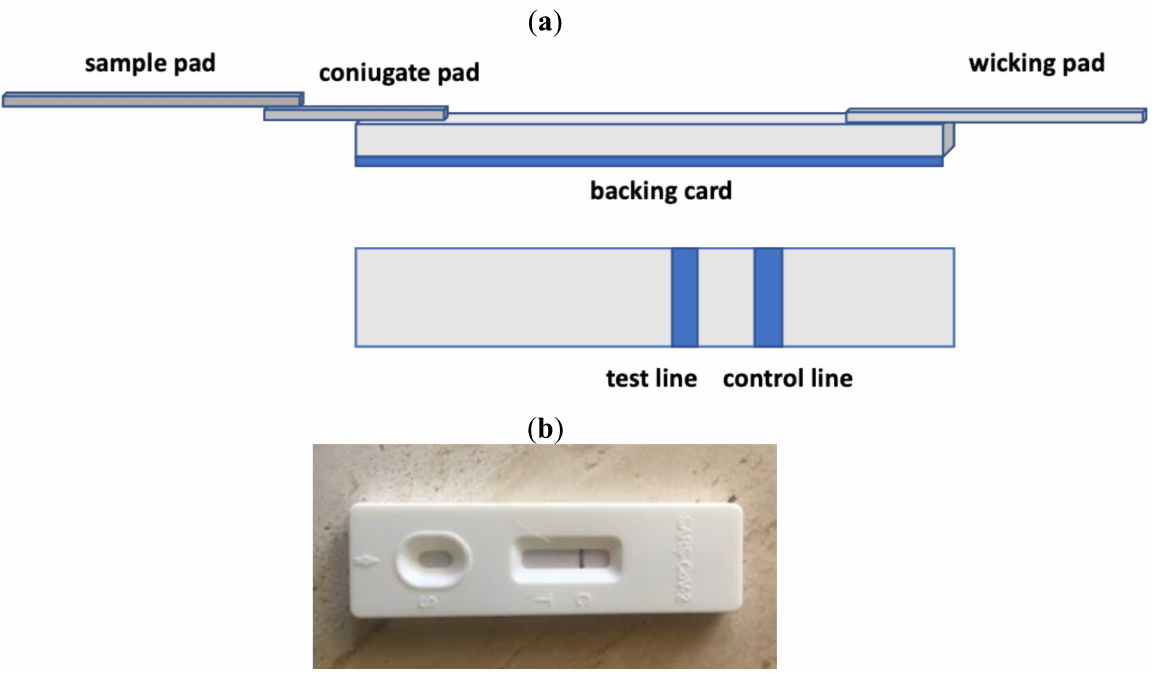
Figure 4. Schematic representation of a lateral flow immunoassay (LFIA) strip ( a ); a commercial lateral flow immunoassay test ( b ). When a sample containing the analyte is applied to the sample pad, a specific reagent with the target analyte migrates to the conjugate pad, forming a colored line in both the test and control lines. If no analyte is present in the sample, only the control line is